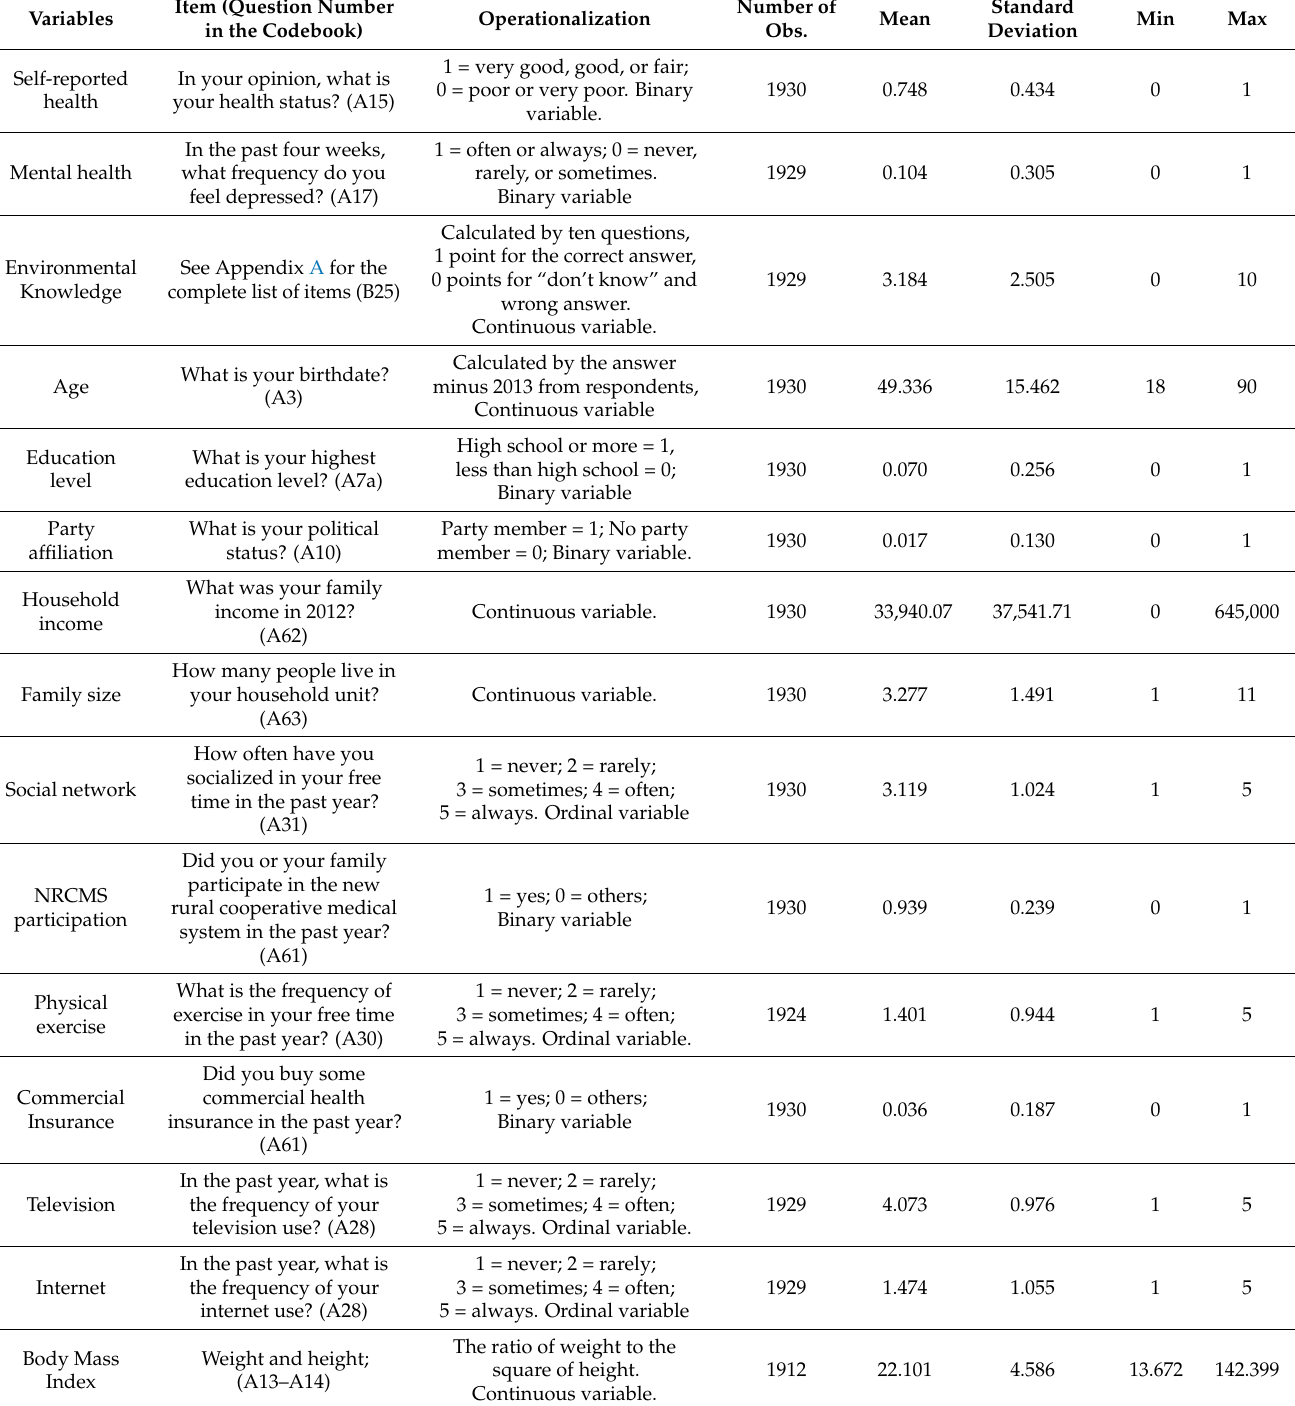
Table 1. Descriptive statistics of